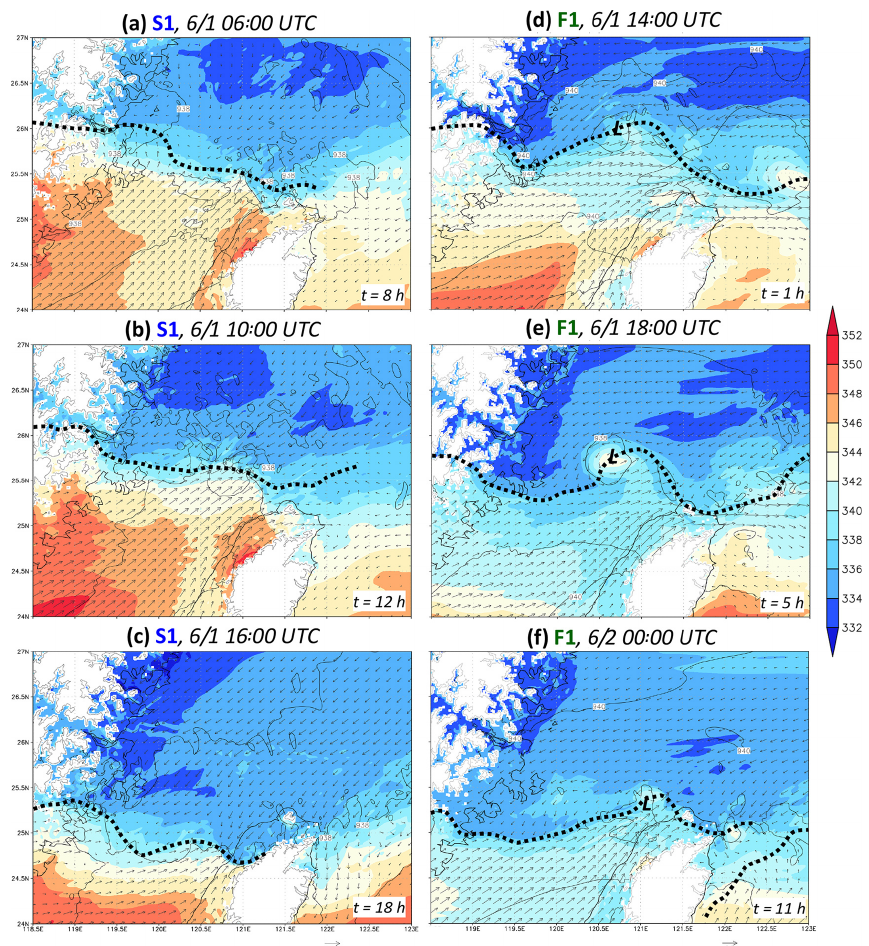
Figure 15. Model pressure (hPa, isobars every 2hPa), horizontal winds (ms − 1 , reference vector at bottom), and equivalent potential tem- perature ( θ e , K, color) at the height of 575m near northern Taiwan at (a) 06:00, (b) 10:00, and (c) 16:00UTC on 1 June 2017 in the S1 experiment. (d–f) As in (a) – (c) , except at (d) 14:00 and (e) 18:00UTC on 1 June and (f) 00:00UTC on 2 June in the F1 experiment. The height contours at 575m are plotted over land (gray), and the wind-shift lines are also depicted (thick dashed